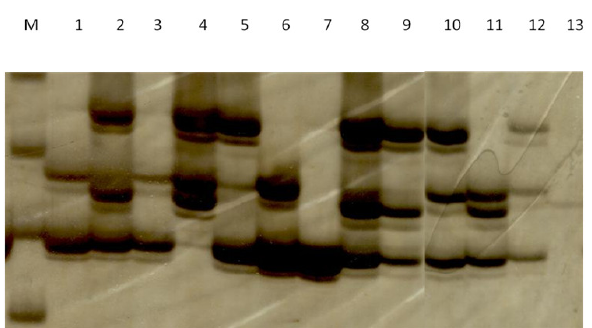
Fig. 1. Segregation of alleles of an SSR8 marker observed on 6% polyacrylamide gel in Opuntia ficus-indica cultivars. Lanes 1 to 13 correspond to accessions listed in Table 1; Lane M, molecular mass marker (10 bp DNA